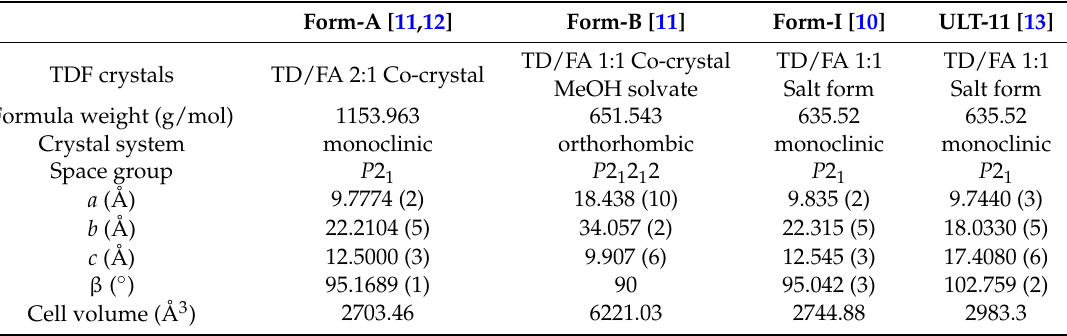
Table 1. Crystallographic data for the known TDF